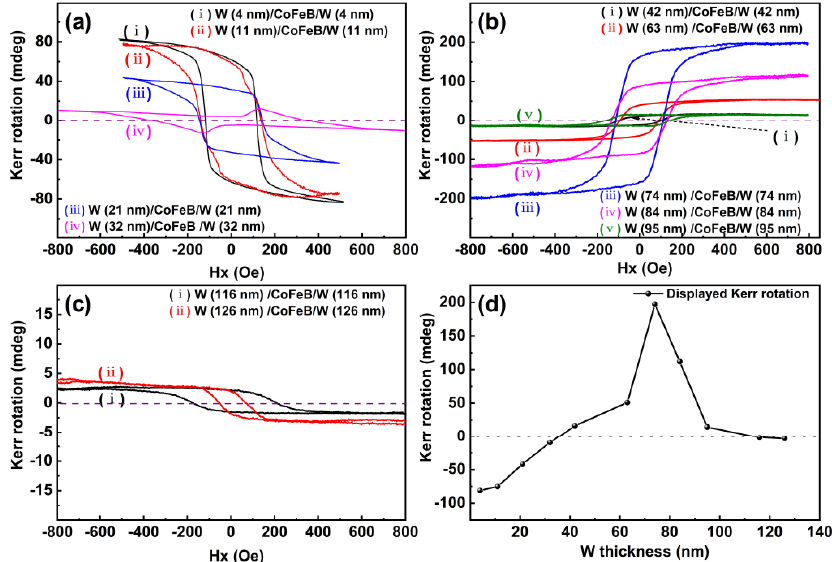
Figure 8. Magneto-optical hysteresis loops versus magnetic-field strength of AAO patterned with multilayered W/CoFeB/W structures. The W thickness is ( a ) 4~32 nm, ( b ) 42~95 nm, and ( c ) 116~126 nm. ( d ) The W thickness-dependent saturated Kerr rotation angle at the positive saturation magnetic field corresponding to the positive hysteresis loop (e.g., the case with the W thickness of 74 nm).